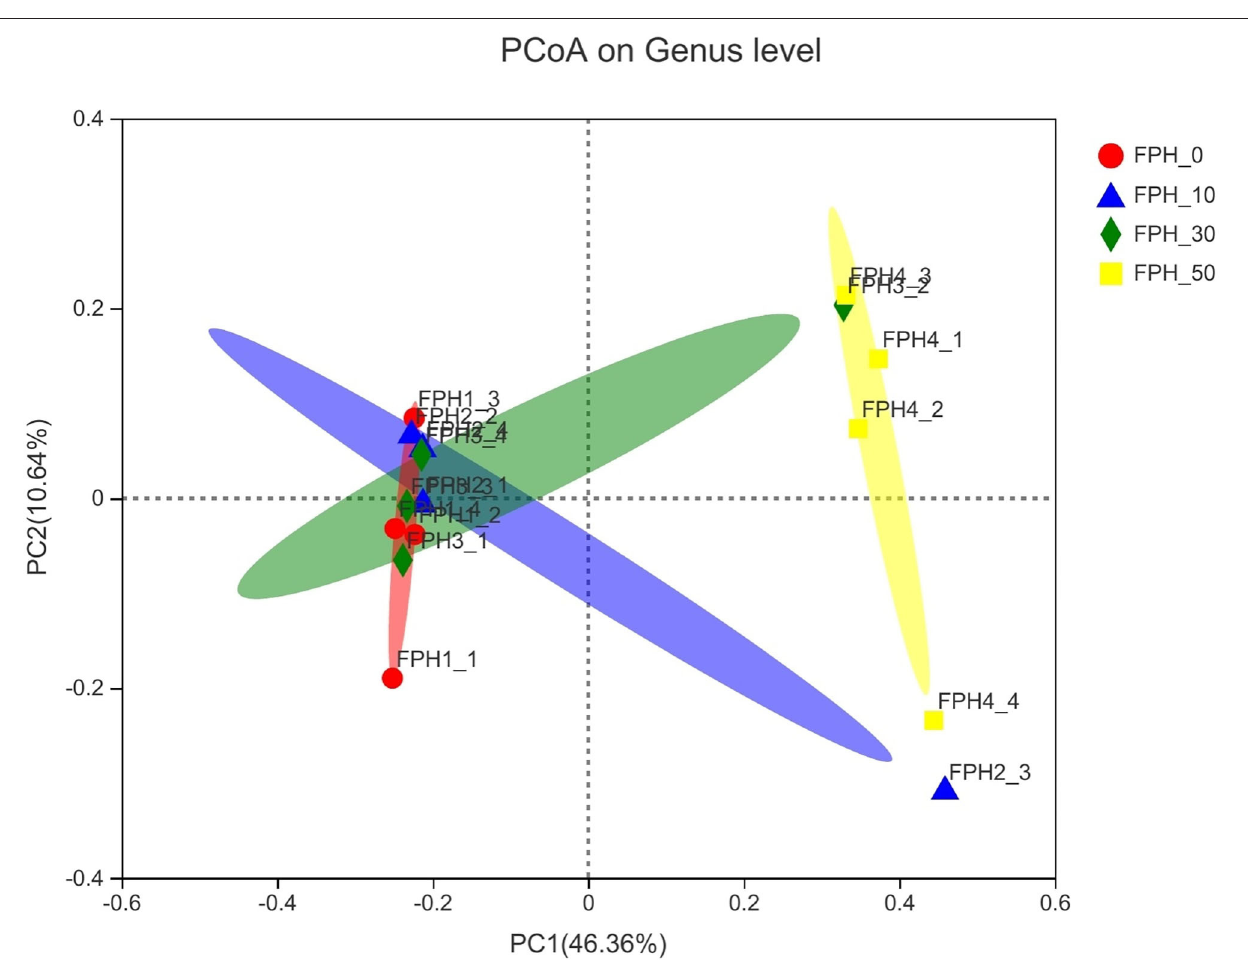
ability, 30 g/kg FPH replacing fish meal in large bass